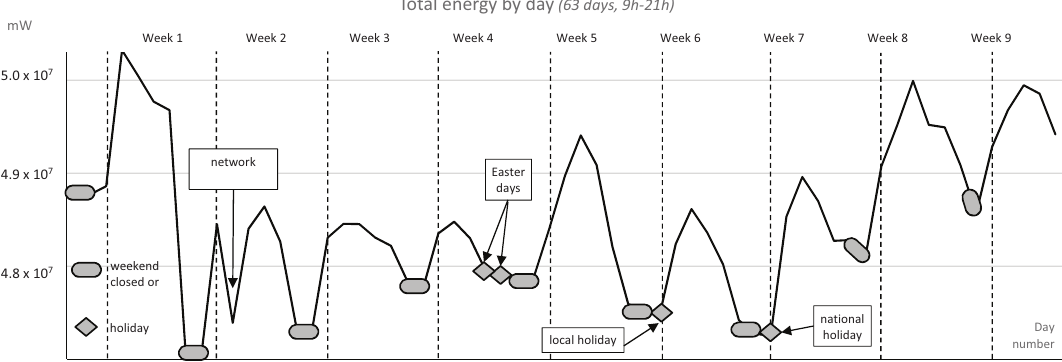
Figure 7. Daily evolution of the energy of the access points in the new period for validation purposes, considering the time slot from 9:00 to